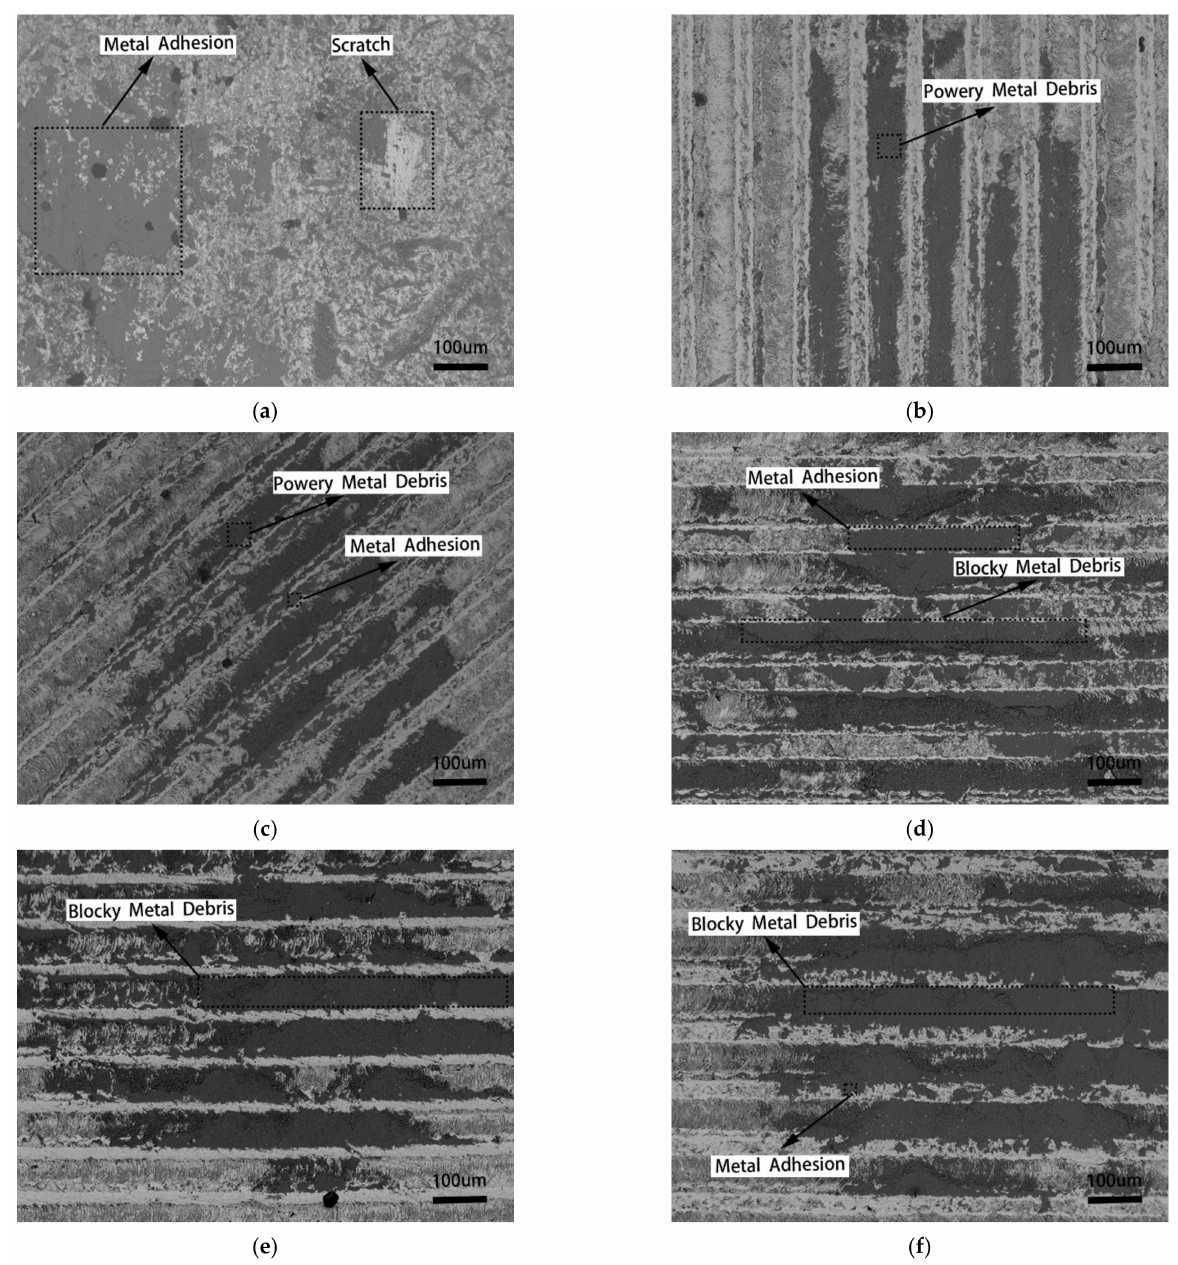
Figure 6. The wear morphology of micro-groove cemented carbide. ( a ) Conventional surface; ( b ) PE micro-grooves; ( c ) OB micro-grooves; ( d ) PA-1 micro-grooves; ( e ) PA-2 micro-grooves; ( f ) PA-3